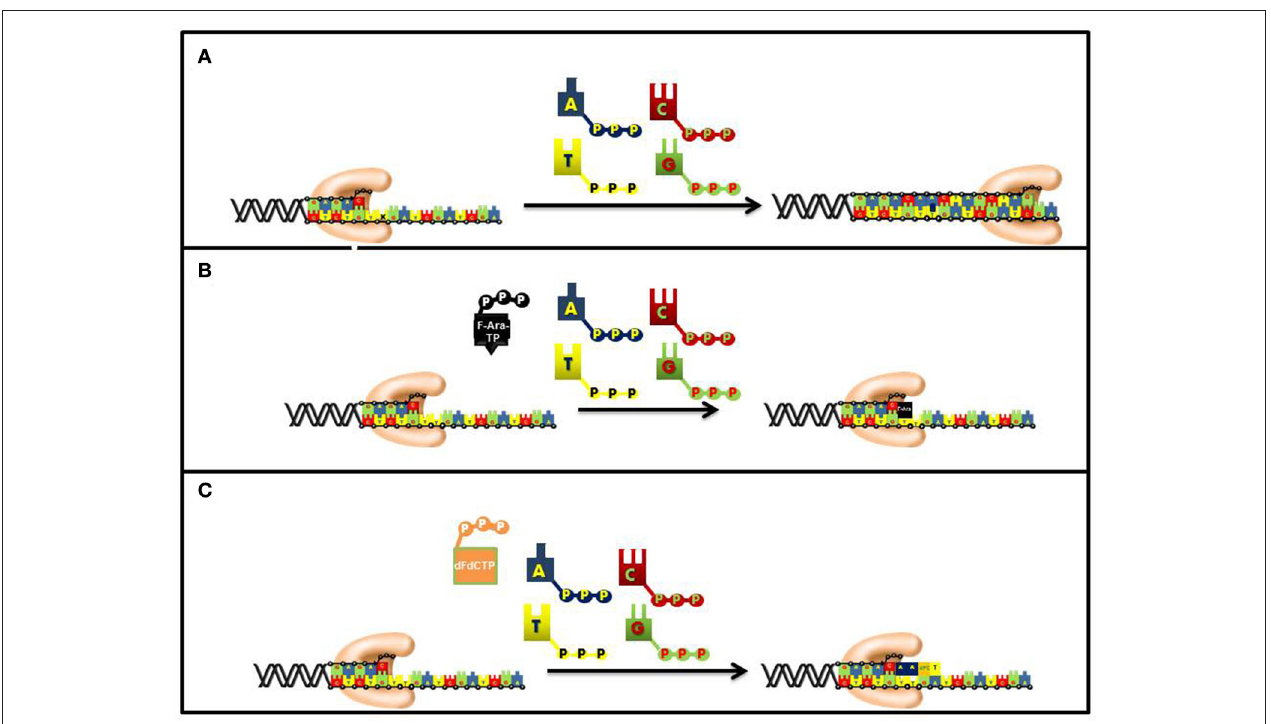
FIGURE 6 | Differences in the mechanism of chain termination by gemcitabine and ara-C. After incorporation into DNA, ara-CTP terminates DNA synthesis directly at the site of incorporation while gemcitabine can be elongated by one additional nucleotide. The placement of gemcitabine at the penultimate position is termed “masked chain termination” since the terminal nucleotide masks detection and removal of gemcitabine by exonucleases or DNA repair enzymes. (A) Normal DNA synthesis. (B) Inhibition by fludarabine. (C) Inhibition by